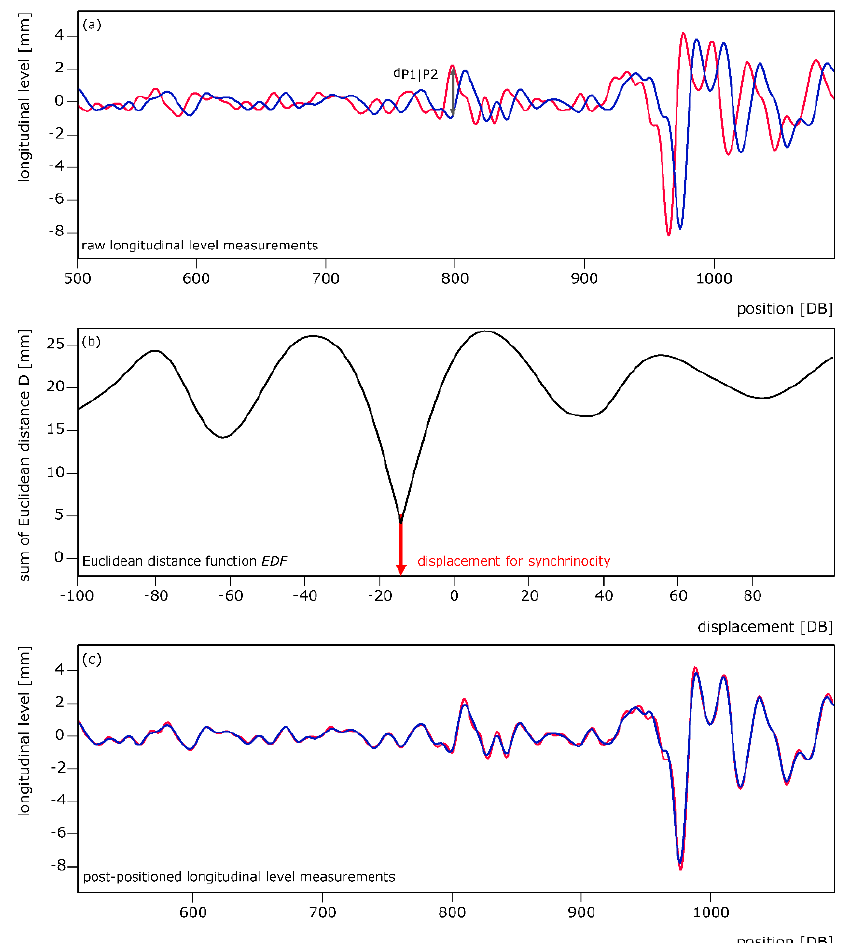
Figure 1. Applying the CoMPAcT-algorithm for reliable time-rows and robust forecasting of Lon- gitudinal Level. ( a ) raw longitudinal level measurements ( b ) Euclidean distance function ( c ) post- positioned longitudinal level measurements